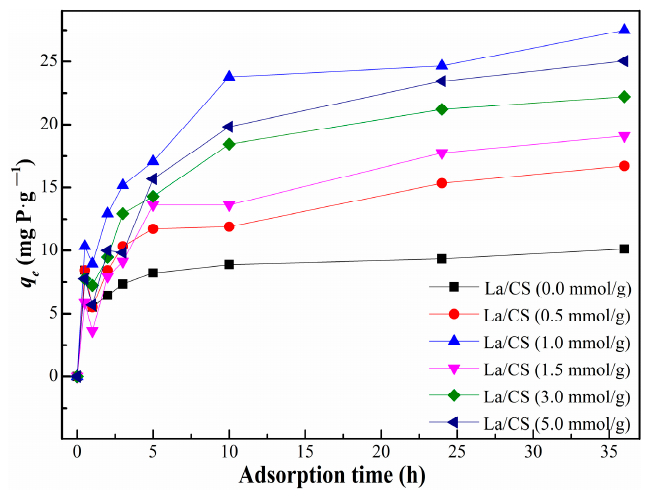
Figure 8. Effect of La/CS ratios on phosphate adsorption capacity of La-chitosan magnetic spheres.